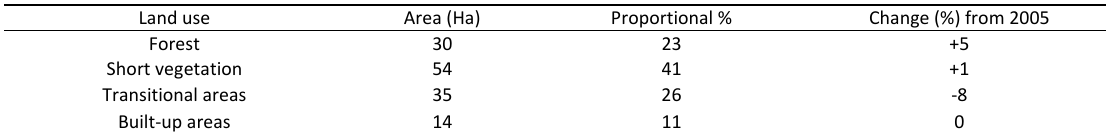
Table 3: Land use in 2014